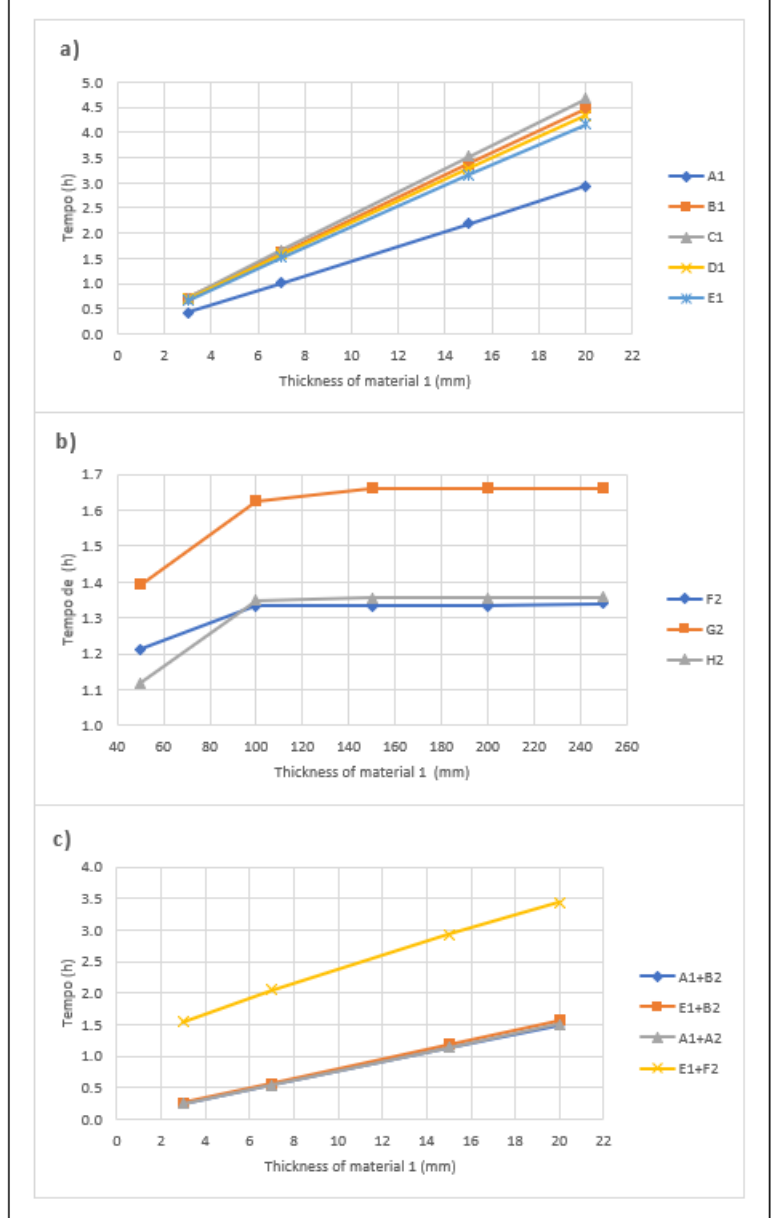
Figure 6. Heating time for different thicknesses and configurations. ( a ) metallic materials (configu- ration I); ( b ) ceramic materials (configuration I); and ( c ) material composition (configurations II or III-on-pivoting sidewall).